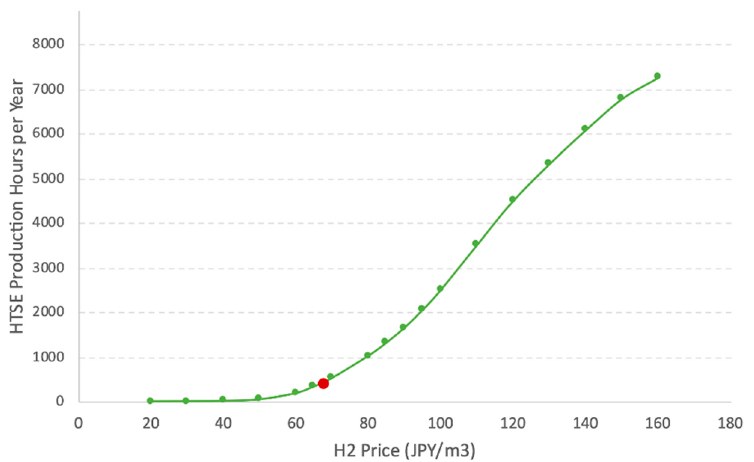
Figure 8. Utilization rate of the IS unit, plotted against the hydrogen price in the stochastic optimization scenario. As the hydrogen price rises, hydrogen deployment becomes increasingly more economically advantageous than electricity sale. Thus, the number of hydrogen production hours increases. The red dot represents the breakeven LCOH.